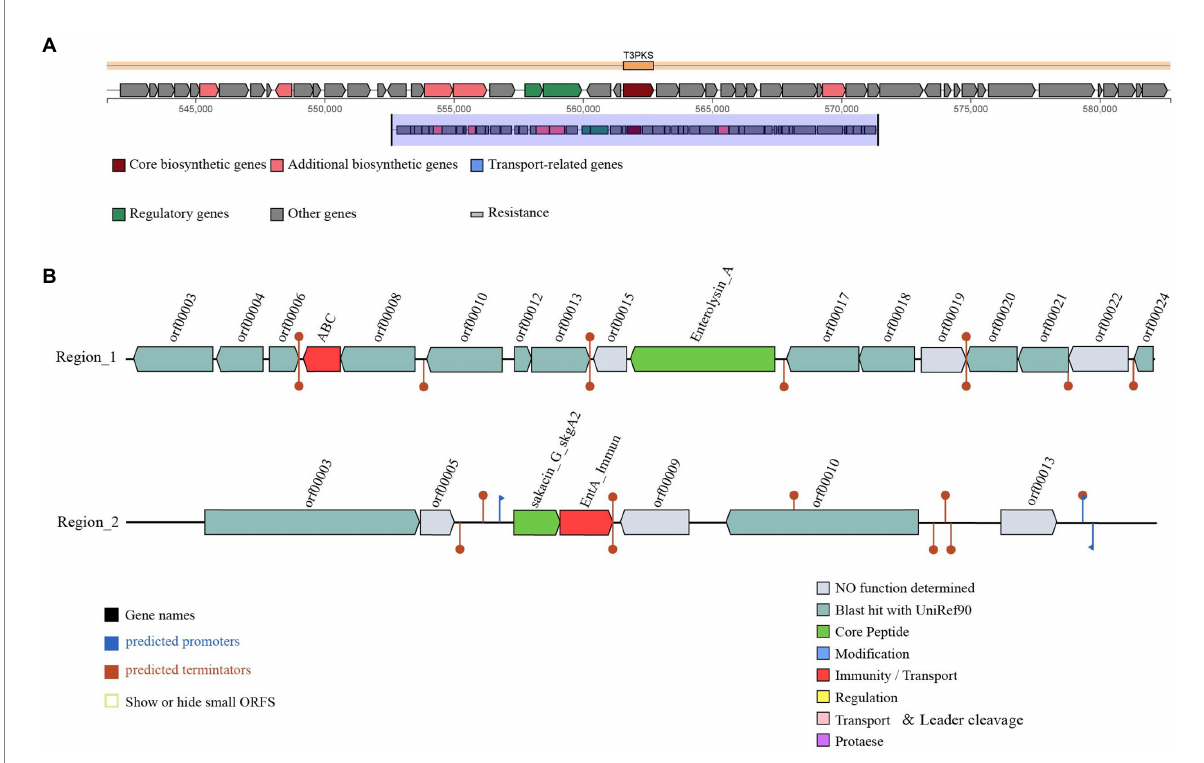
FIGURE 3 Prediction of antimicrobial-associated protein structures in the genome of L. salivarius S01. (A) Synthetic gene cluster of polyketide synthase (T3PKS; based on antiSMASH database prediction). (B) Two bacteriocin (region_1: Enterolysin_A and region_2: Sakacin_G) synthesis gene clusters (predicted based on the BAGEL4 database).